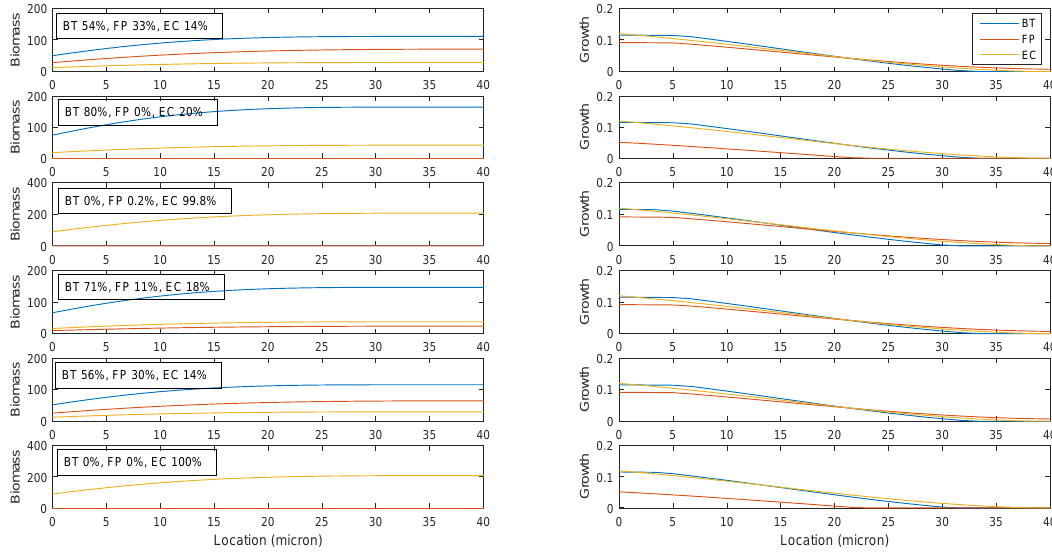
Figure 6. Steady-state biomass concentration ( left ) and growth rate ( right ) spatial profiles predicted with different cross-feeding relationships. Each row represents a different cross-feeding pattern. Row 1: Scenario 1. The same results were obtained for scenario 8. Row 2: Scenario 2. The same results were obtained for scenarios 3 and 6. Row 3: Scenario 4. Row 4: Scenario 5. Row 5: Scenario 7. Row 6: Scenario 9. Units are g/L for biomass and h − 1 for growth rates. The average species abundances across the biofilm are shown for each case.